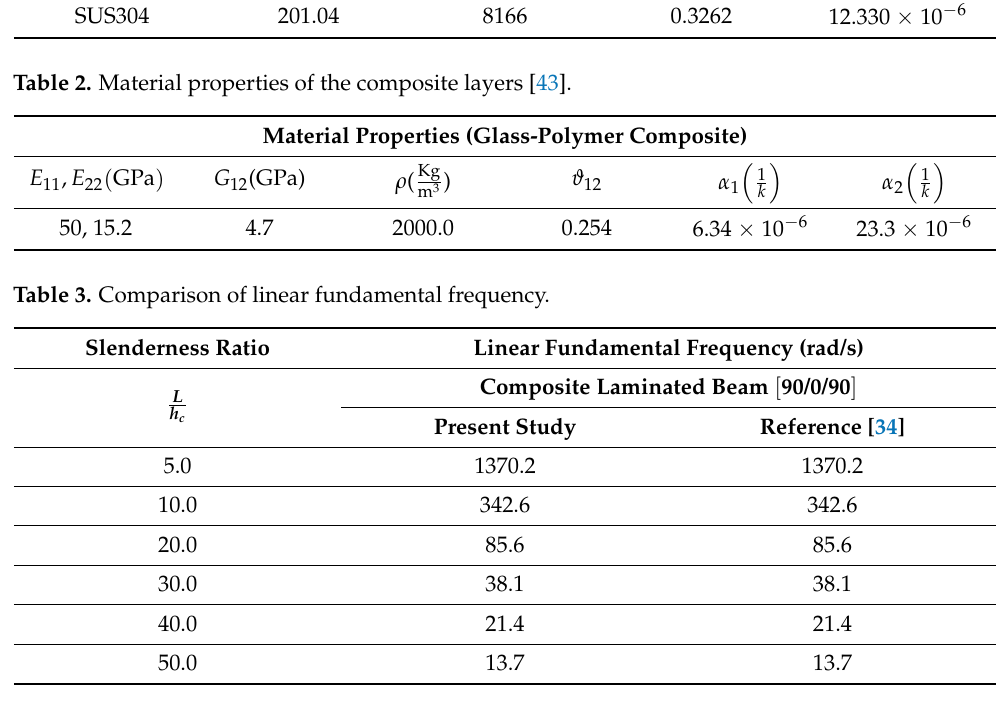
Table 4. Comparison of linear and nonlinear fundamental